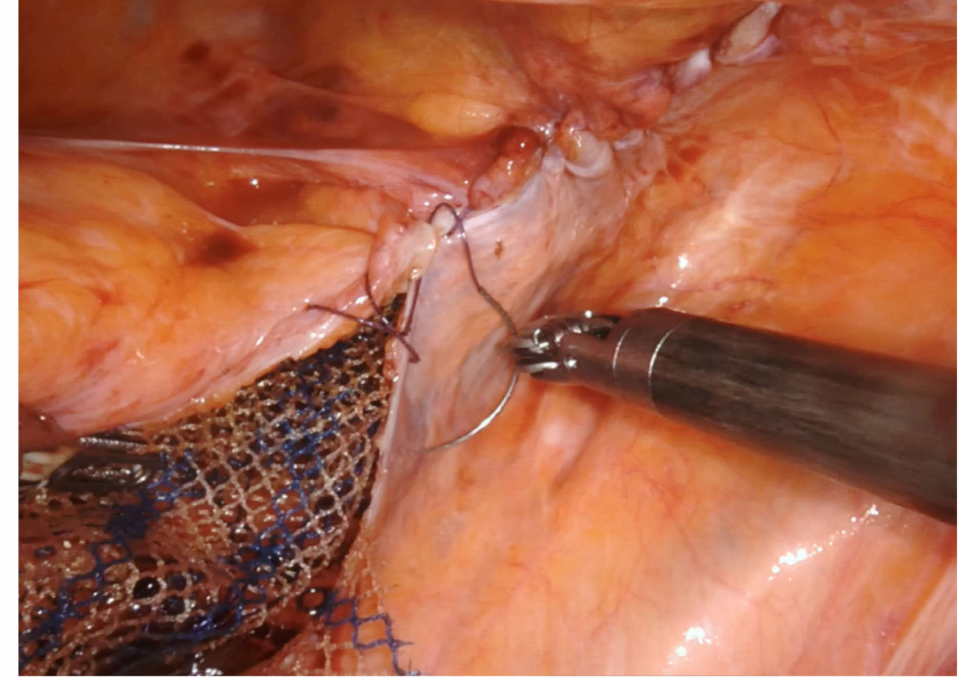
Figure 5. The peritoneum is closed with absorbable barbed running